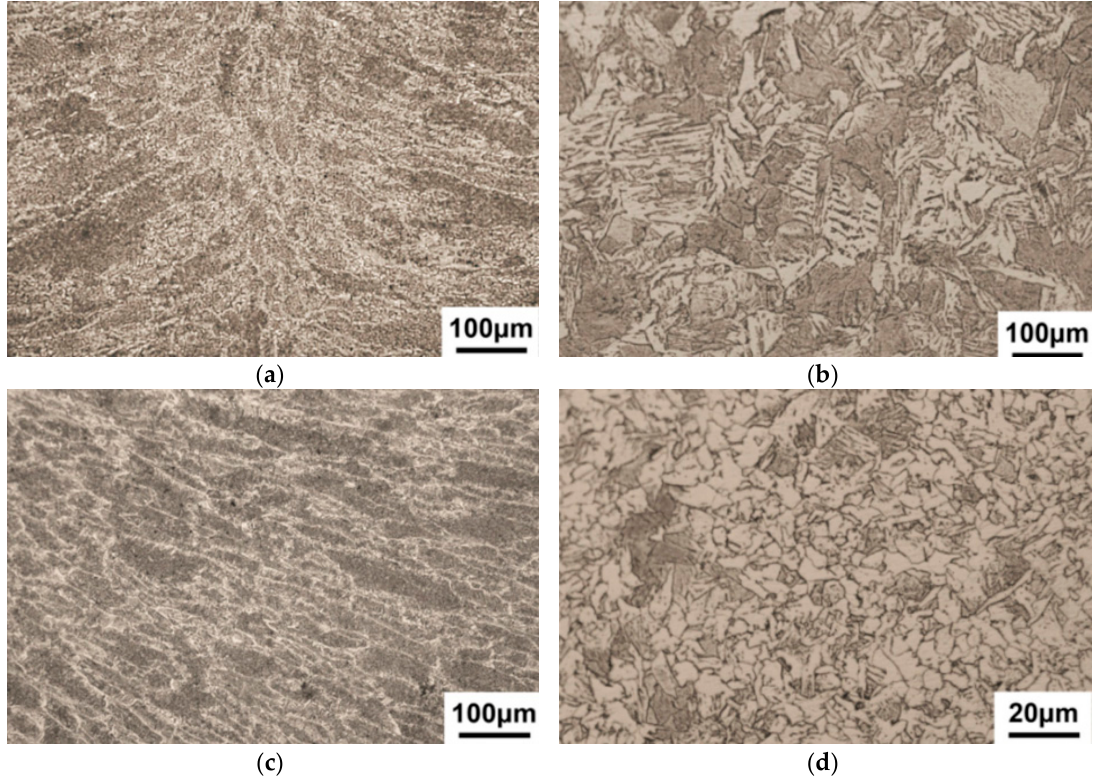
Figure 17. Microstructures evolution in multi-passes LAHW: ( a ) laser zone and ( b ) its HAZ, ( c ) arc zone and ( d ) its HAZ (reproduced from [50] with permission, MDPI, 2017). Macrographic image of the whole weld is shown in Table 11 R.